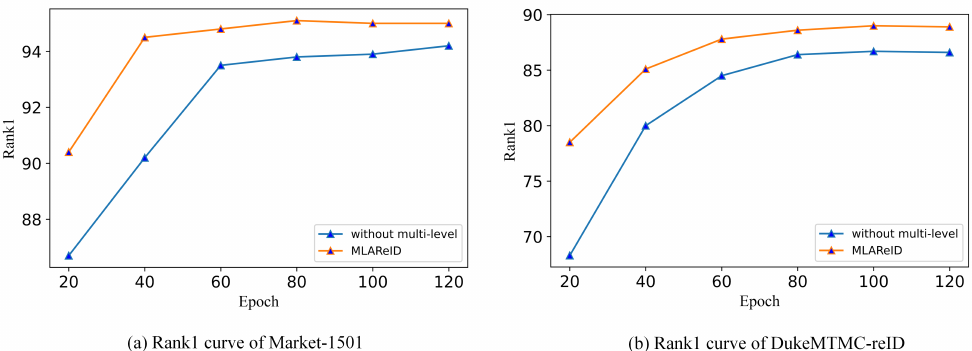
Figure 7. Whether to add multi-level fusion module on different datasets (Rank1). Compared with without multi-level network, the proposed method achieves better Rank1 in training